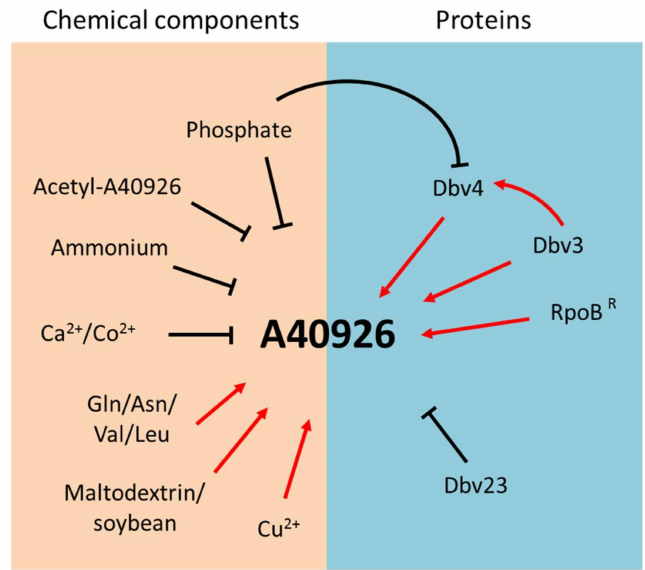
Figure 4. Nutrients, biosynthetic products and proteins regulating A40926 production in Nonomuraea gerenzanensis